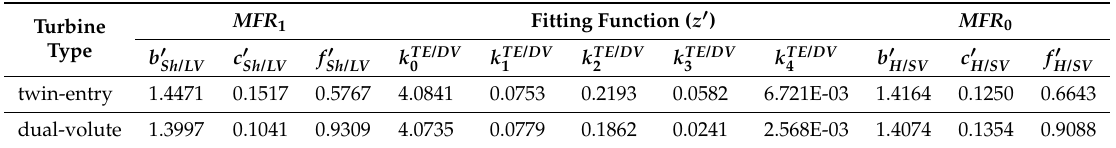
Table 6. Final apparent efficiency fitting coefficients for both T#1TE and T#2DV turbochargers. Model constants for both turbines are found in a global fitting using both branches together and all the MFR s data points.